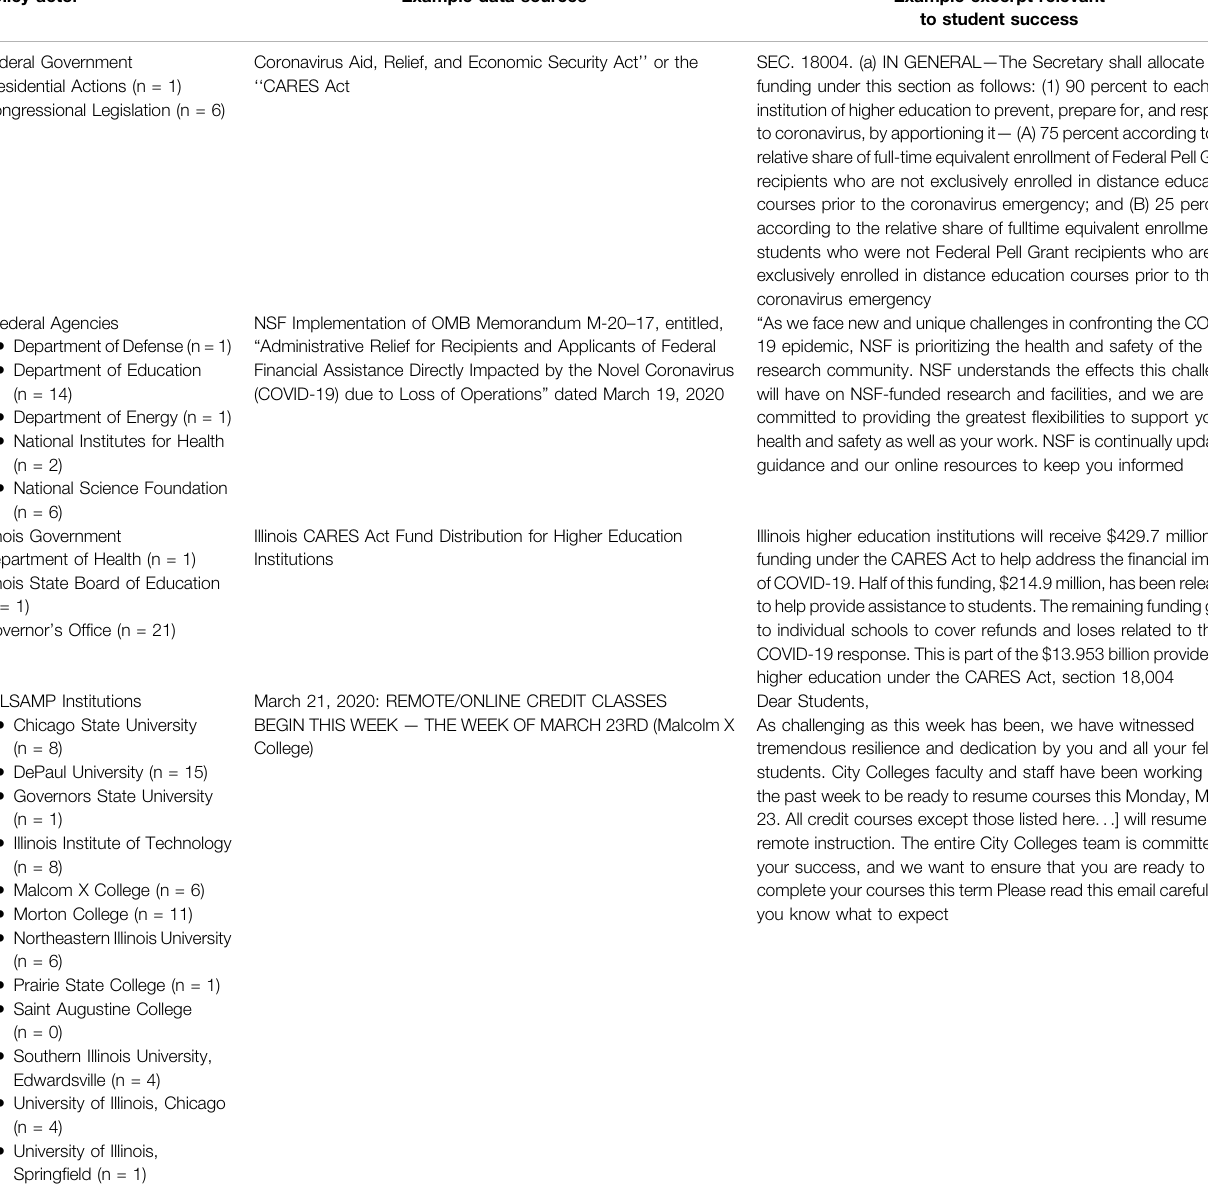
TABLE 2 | Overview of data sources and representative examples. Policy actor Example data